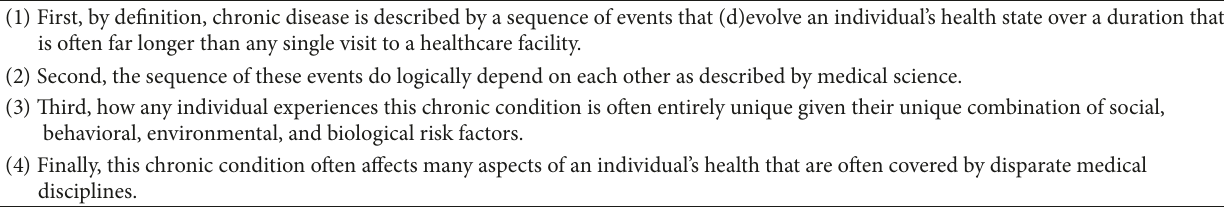
Table 1: Healthcare delivery challenges for chronic